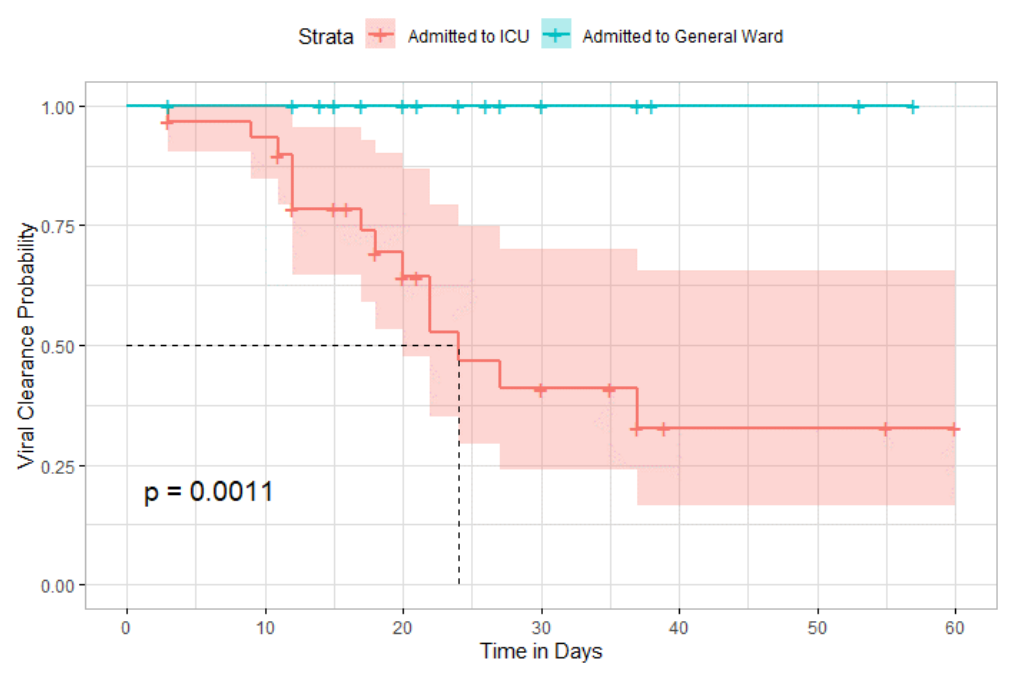
Figure 10. Kaplan–Meier curve comparing the time until viral clearance between ICU admitted Figure 10. Kaplan – Meier curve comparing the time until viral clearance between ICU admitted pa- tients and general ward. patients and general